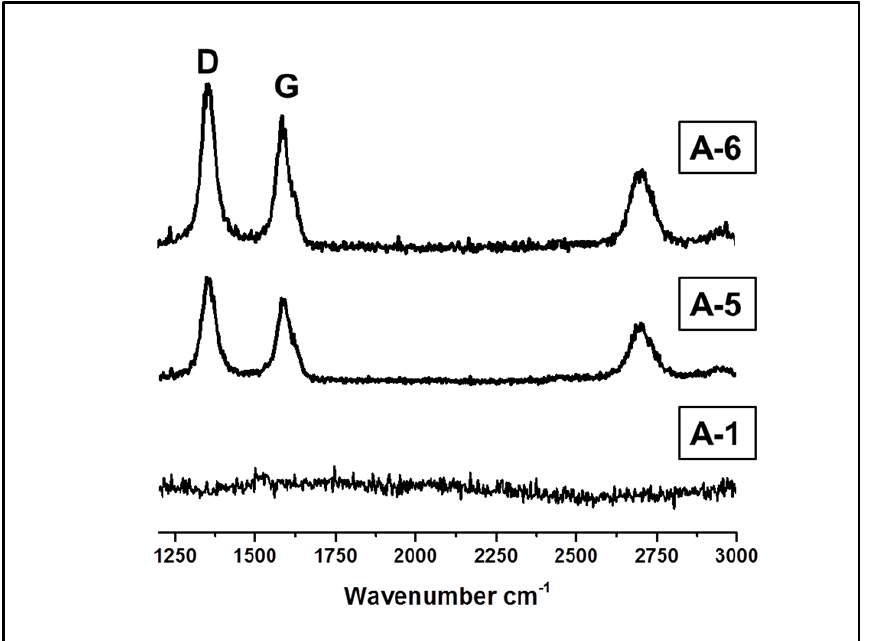
Figure 8. Raman spectra for SiC/C f microspheres. DVB/PHMS w / w ratio: A-1 = 0.17, A-5 = 0.80, A-6 = 0.97. Table 3. Results of Raman studies of SiC/C f microspheres.